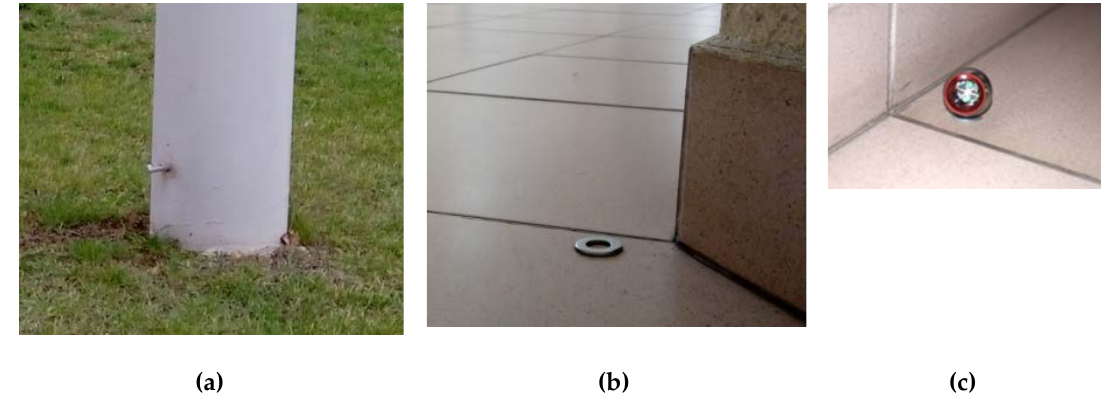
Figure 4. Measurement marks: ( a ) stabilization of outdoor marks at the base of the pillar; ( b ) stabilization of indoor marks on the floor of overhead passage; ( c ) view 1.5" RRR prism on the floor mar3. Results.